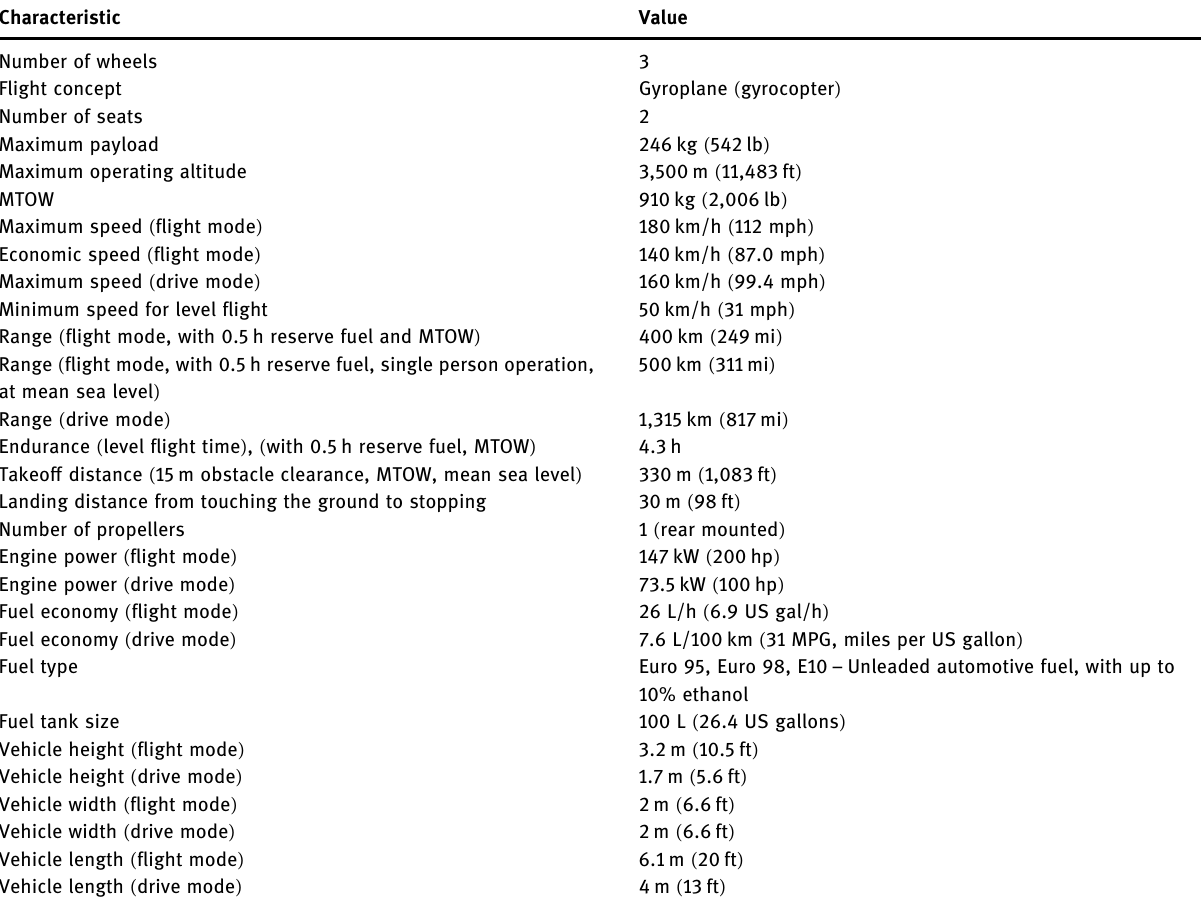
Table 3: Some characteristics of the PAL - V liberty sport fl ying car Characteristic